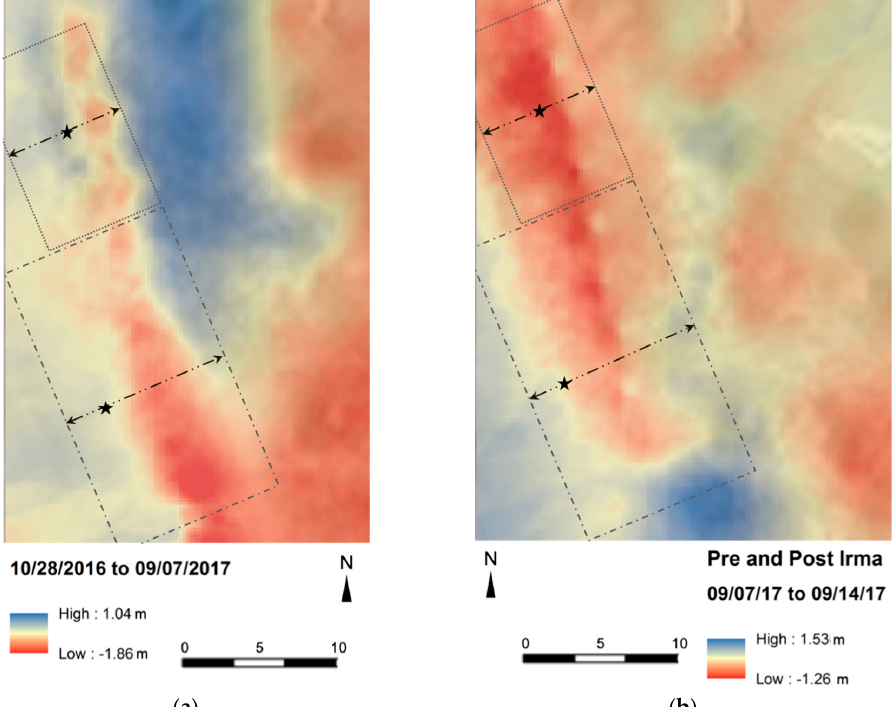
Figure 6. DEM change maps where red and blue hues show erosion and accretion, respectively. The secondary dunes are to the right of the dotted boxes. The mechanical and natural dunes (according to the 10 / 28 survey) are delineated by grey dotted and dash-dotted boxes, respectively. Black stars show the location of the onshore side of the dune toe. ( a ) Change from 10 / 28 to 09 / 07 represents the recovery following Hurricane Matthew. ( b ) Change from 09 / 07 to 09 / 14 isolates the change from Hurricane Irma. The locations of the profiles (see Figure 7) are designated by the black dashed-dotted arrows. DEM-based profiles extracted at the approximate midpoint of the natural and mechanical dunes are shown in Figure 7a and b, respectively. We present the three key dates, which allow us to highlight: 1) the Hurricane Matthew recovery using data following Hurricane Matthew (2016) to just prior to Hurricane Irma (10/28-09/07); and 2) the impact of Hurricane Irma using pre and post- Hurricane Irma data (09/07-09/14). During the ~10 months following Hurricane Matthew (10/28- 09/07), the natural dune (Figure 7a) mainly accreted. The landward migration of the mechanical dune is evident in Figure 7b. Also visible on the mechanical dune profile (Figure 7b) is the shoreface erosion/deflation (see distances 0-2 m). Similar to the DEMs (Figure 6), the substantial erosion associated with Hurricane Irma is evident in the dune profiles (Figure 7). Hurricane Irma resulted in approximately 4 m and 2 m of landward dune erosion at the natural and mechanical site, respectively. The natural dune was scarped.